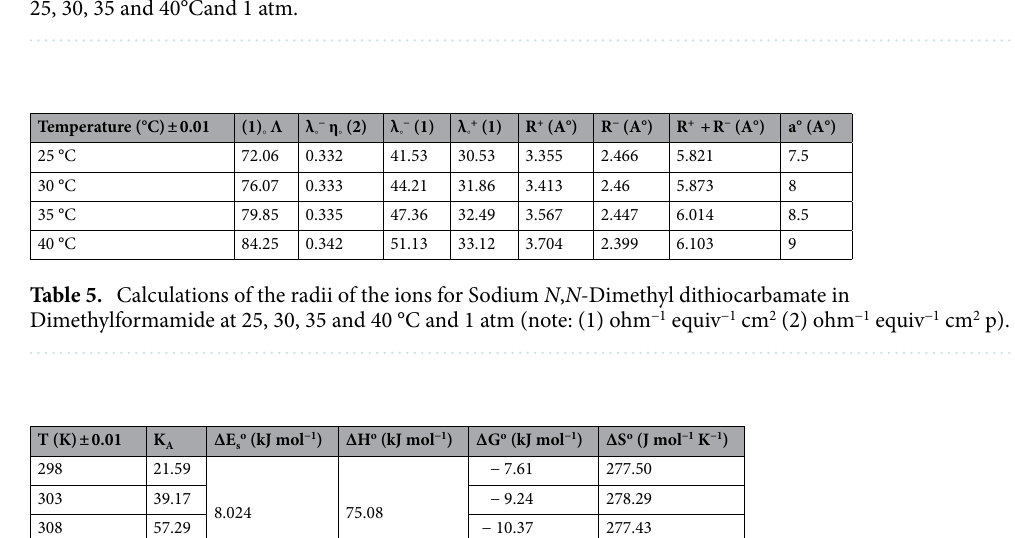
Table 6. Thermodynamic parameters of Sodium N , N -Dimethyldithiocarbamate in Dimethylformamide at 25, 30, 35 and 40 °C and 1 atm.